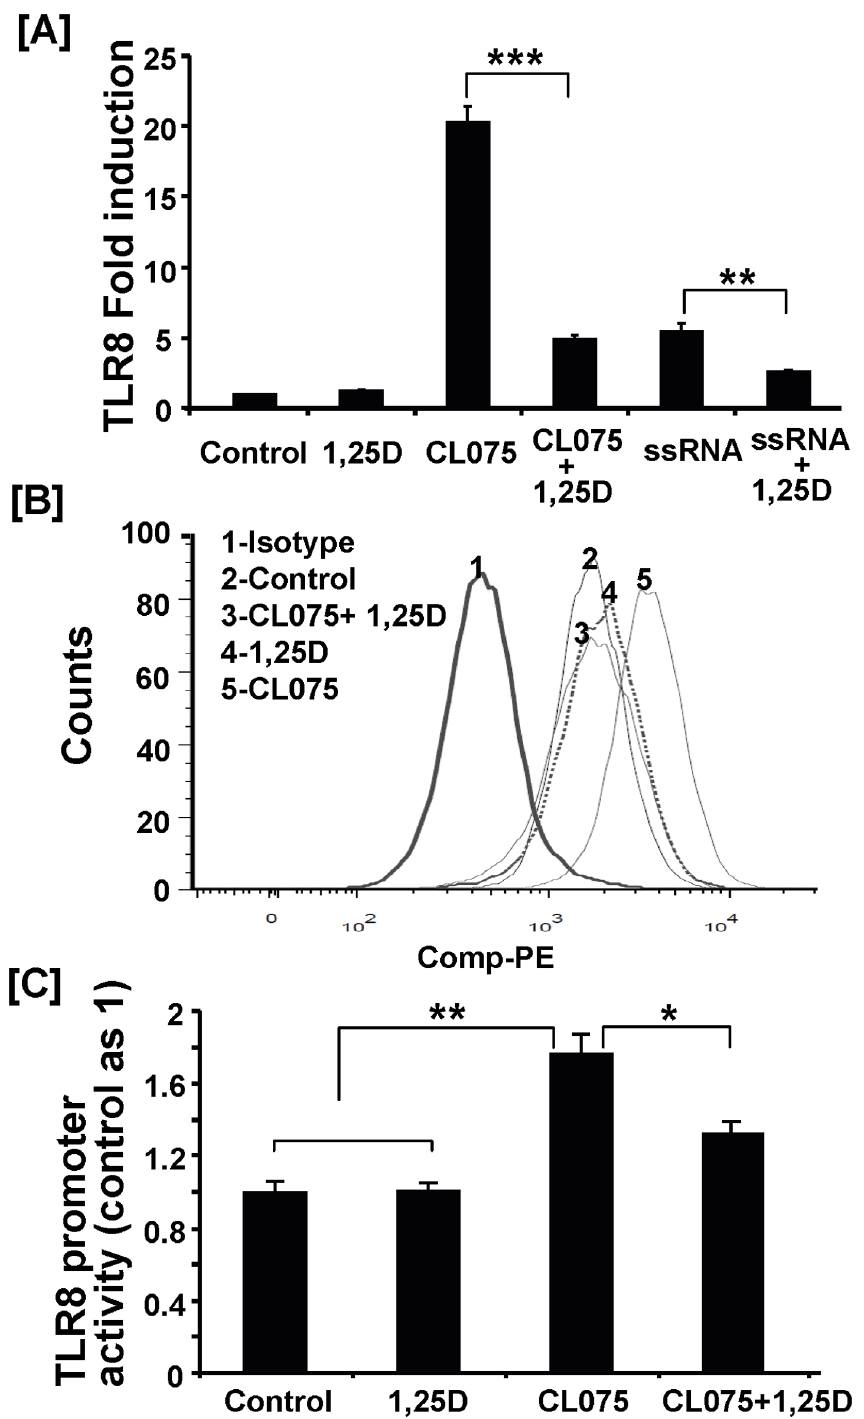
Figure 6. 1,25(OH) 2 D 3 inhibits TLR8 agonist-induced TLR8 expression in human monocytes. THP-1 cell treatment was described in Figure 5A-B legend. ( A ) mRNA level of TLR8 was subsequently determined by real-time RT-PCR. Data shown here represent means 6 SEM (n=4) and are representative of three independent experiments. ( B ) Intracellular expression of TLR8 was analyzed by FACS analysis using PE-conjugated anti- TLR8 antibody ( Material & Methods ). Isotype control antibody was used as negative control for non-specific TLR8 staining. A representative histogram plot was shown here from three independent experiments. ( C ) The THP-1 cells were co-transfected with TLR8 promoter-luciferase and TK-Renilla plasmid as described in Material and Methods . After 24 h, cells were pretreated with 1,25(OH) 2 D 3 (100 nM) for 30 min and then stimulated with CL075 (4 m g/ml) for 20 h. The TLR8 promoter activity was presented as the ratio of luciferase activity to TK-Renilla activity. The data shown are means 6 SEM (n=4) and representative of two independent experiments. * P , 0.05; ** P , 0.01; ***, P , 0.001.